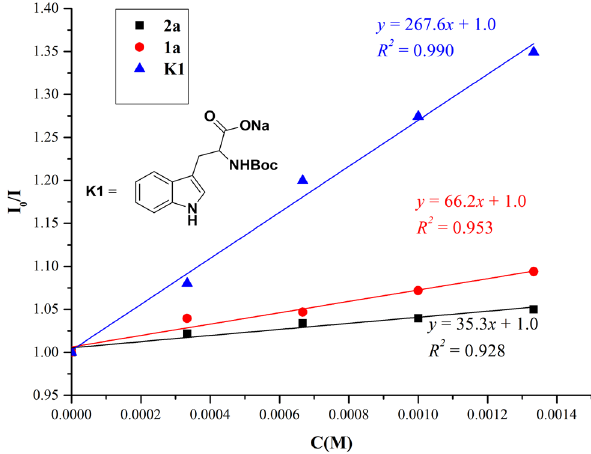
Fig. 5 Stern – Volmer quenching experiments of * Ir[dF(CF 3 )ppy] 2 (dtbbpy) PF 6 with compounds 1a, 2a, and K1. A solution of Ir[dF(CF 3 )ppy] 2 (dtbbpy) PF 6 in N , N -dimethylacetamide was excited at 380 nm and the emission intensity at 481 nm was